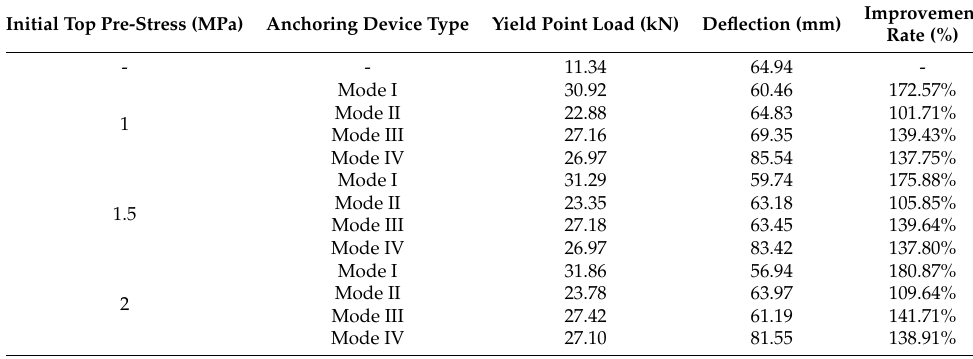
Table 3. Bearing capacity with several top prestress.